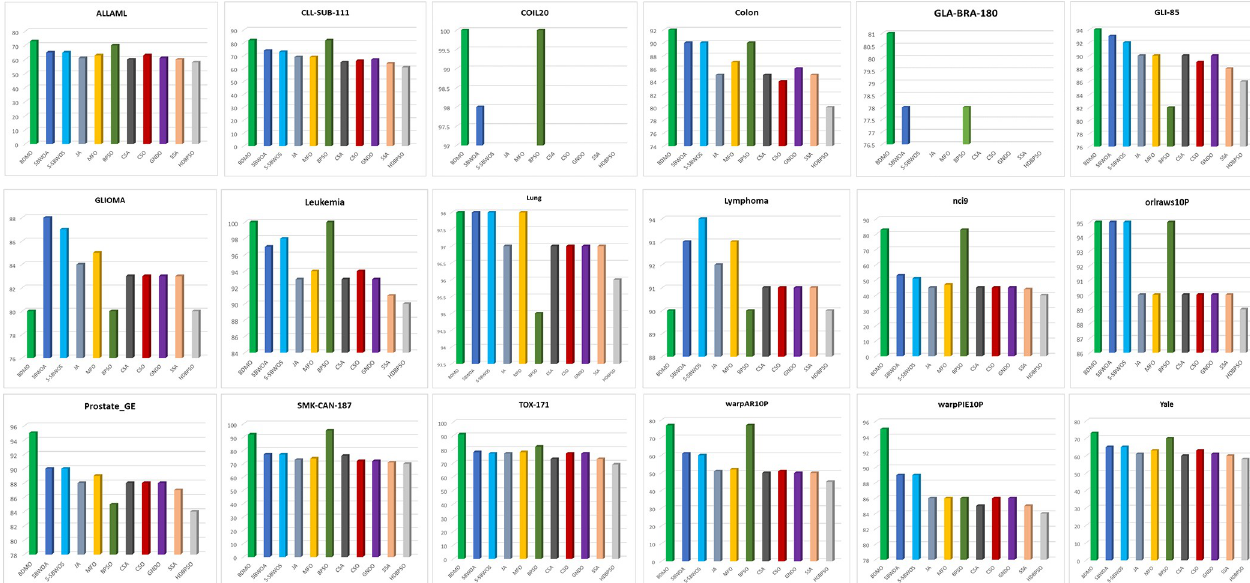
Fig 3. Comparison between the proposed BDMO and the state-of-the-art methods based on accuracy validation on all selected high-dimensional feature selection datasets.